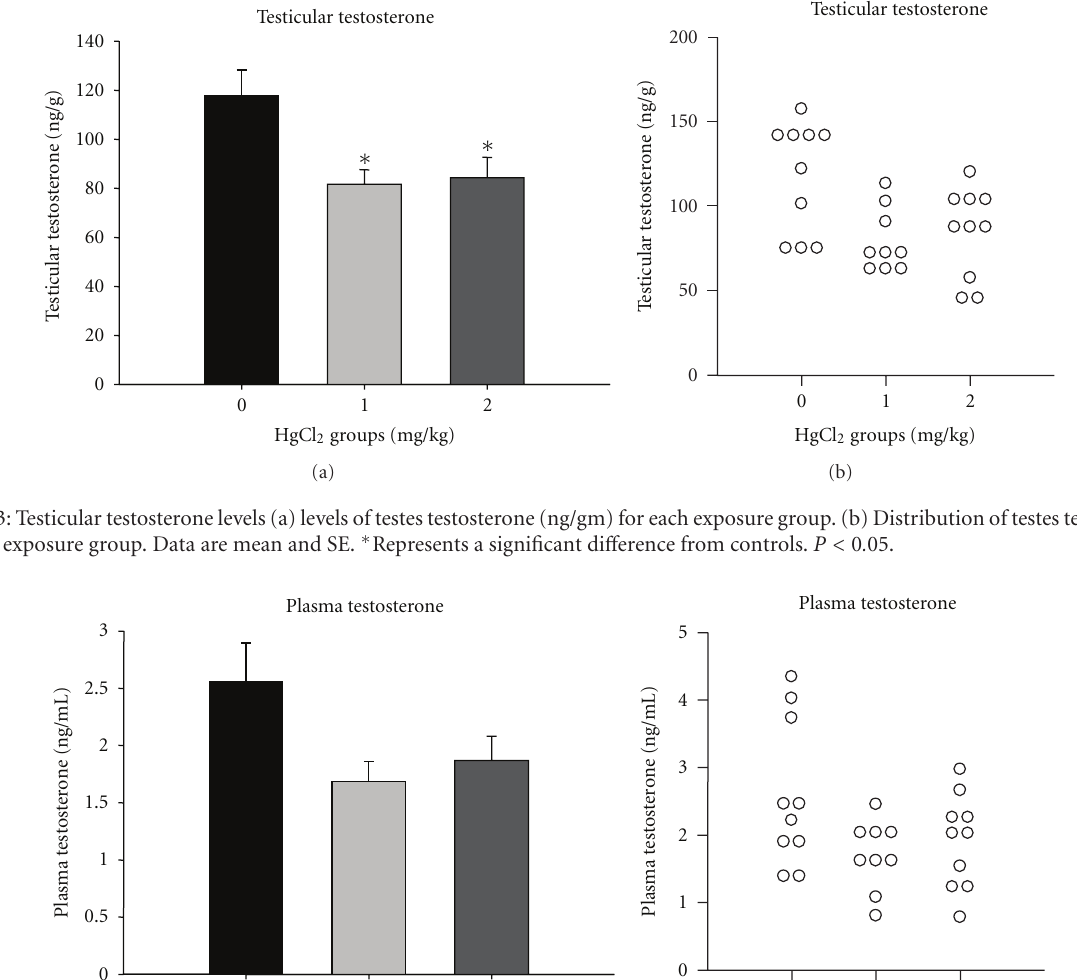
impregnate. Results showed a high correlation ( r = 0 . 9996, P = 0 . 17) between these